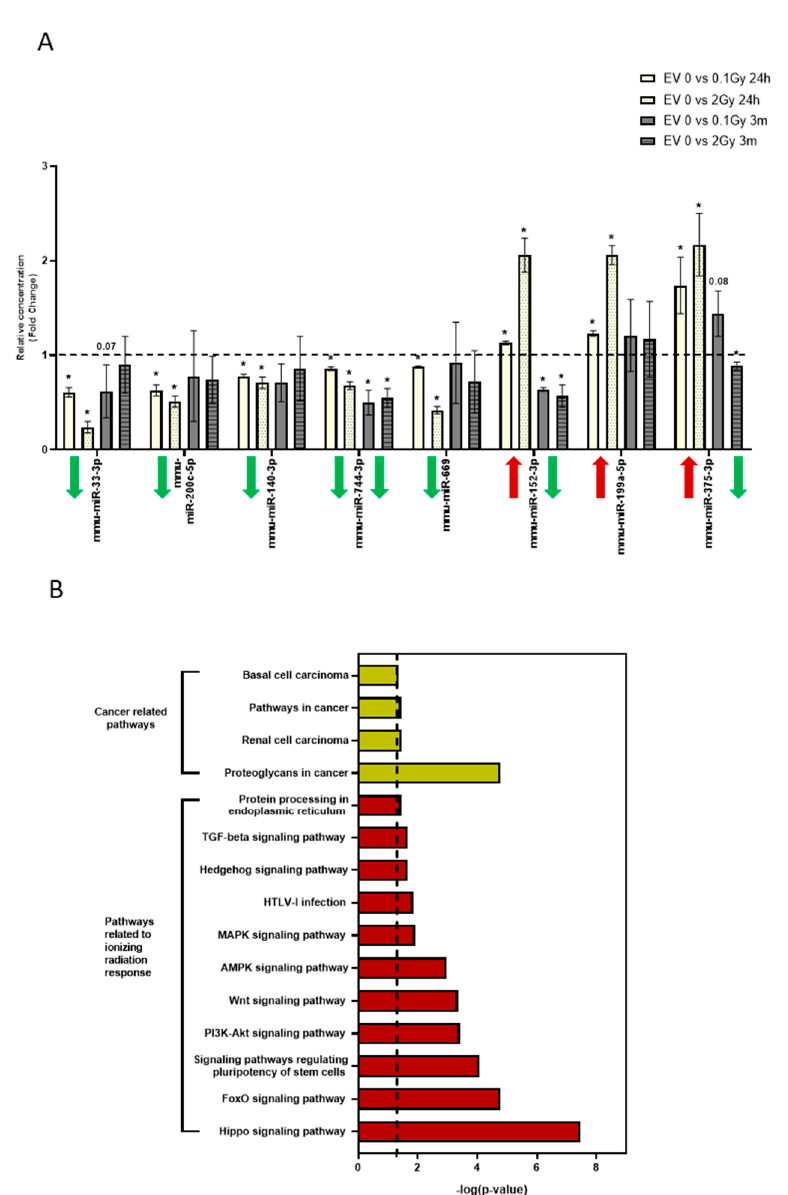
Figure 11. Pathways Related to Cellular Response to Ionizing Radiation Prevail in miRNAs Differ- entially Expressed in the Bone Marrow-Derived Extracellular Vesicles Isolated from Mice 24 Hours after Irradiation. ( A ) Extracellular vesicles were isolated from the bone marrow of mice, miRNAs purified from extracellular vesicles and the relative concentration of miRNAs was measured by qRT-PCR as described in the Materials and Methods section. n = 3; * indicate significant changes ( p < 0.05) compared to control (0Gy extracellular vesicles samples). Arrows show increased (red arrows) or decreased (green arrows) expression in miRNAs from extracellular vesicles isolated 24 h or 3 months after irradiation. ( B ) KEGG analysis of differentially expressed 7 miRNAs in murine bone marrow-derived extracellular vesicles isolated 24 h but not 3 months after irradiation. A pathway was considered significant if the p -value was ˂ 0.05 ( − log10 (0.05) indicated by the dashed line.